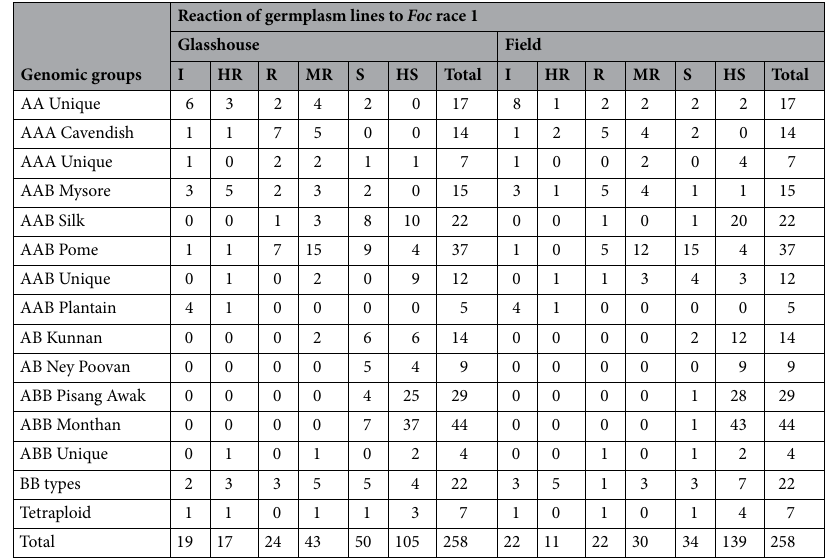
Table 1. Number of genotypes showing different reactions to Foc race 1 (VCG 0124) under glasshouse and field conditions. I-Immune; HR-Highly resistant; R-Resistant; MR-Moderately resistant; S-Susceptible; and HS-Highly susceptible.